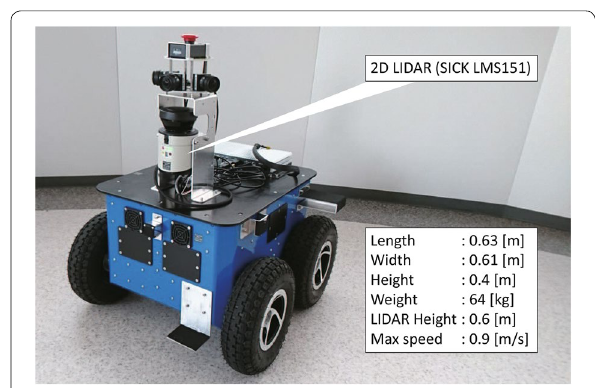
Fig. 24 Mobile robot used in our robot navigation system